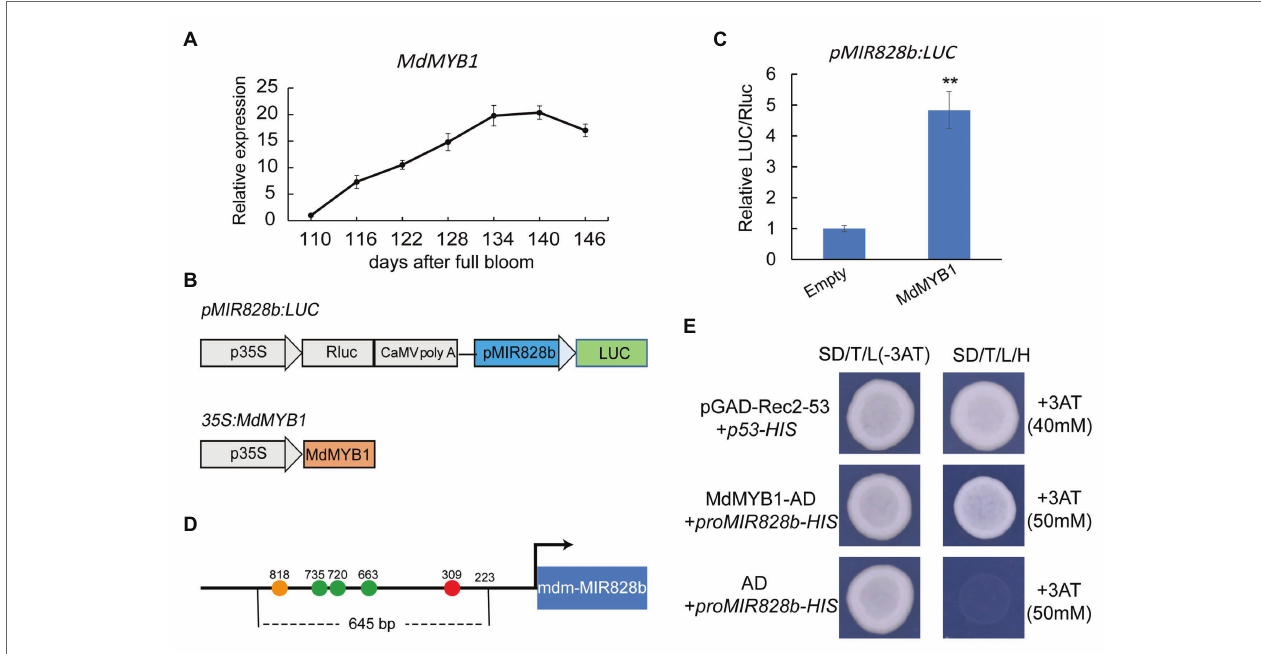
FIGURE 4 | MdMYB1 promotes mdm-MIR828b expression by directly binding to its promoter. (A) Expression pattern of MdMYB1 during the coloration period of apple “Starkrimson Delicious” fruit. (B) Schematic representation of the construct used for the dual-luciferase assay. (C) Relative LUC/REN ratio. REN, Renilla luciferase activity; LUC, firefly luciferase activity. Error bars represent the standard deviation of three biological replicates. ** p < 0.01 (Student t -test). (D) Schematic diagram of the mdm-MIR828b promoter structure. Circles represent the potential MYB transcription factor recognition sites: orange (TAACCA), green (CAACCA), and red (TAACTG). The number represents the distance (bp) from the transcription start site. (E) Yeast one-hybrid assay for binding of the mdm-MIR828b promoter and MdMYB1. pGAD-Rec2-53 and p53-HIS were used as positive